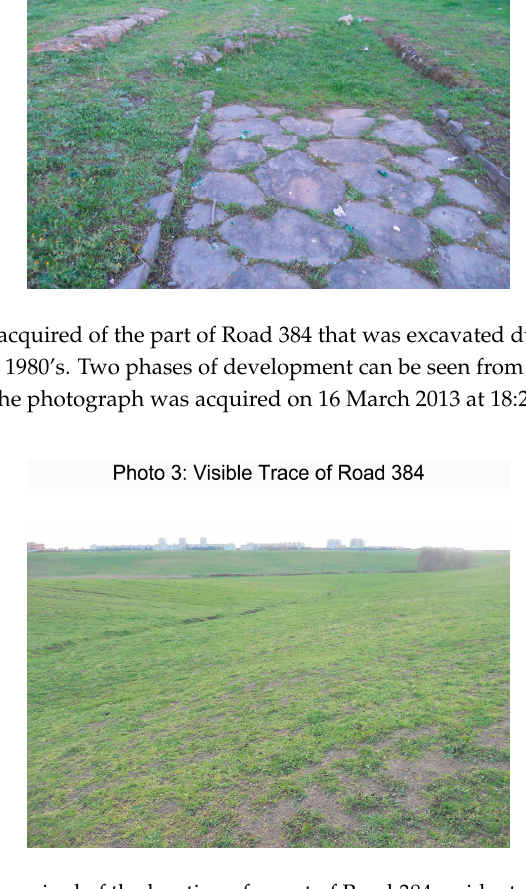
Figure 34. Photograph acquired of the location of a part of Road 384, evident as a narrow trough in the center of a broad valley. The photograph was acquired on 16 March 2013 at 17:01 CET.